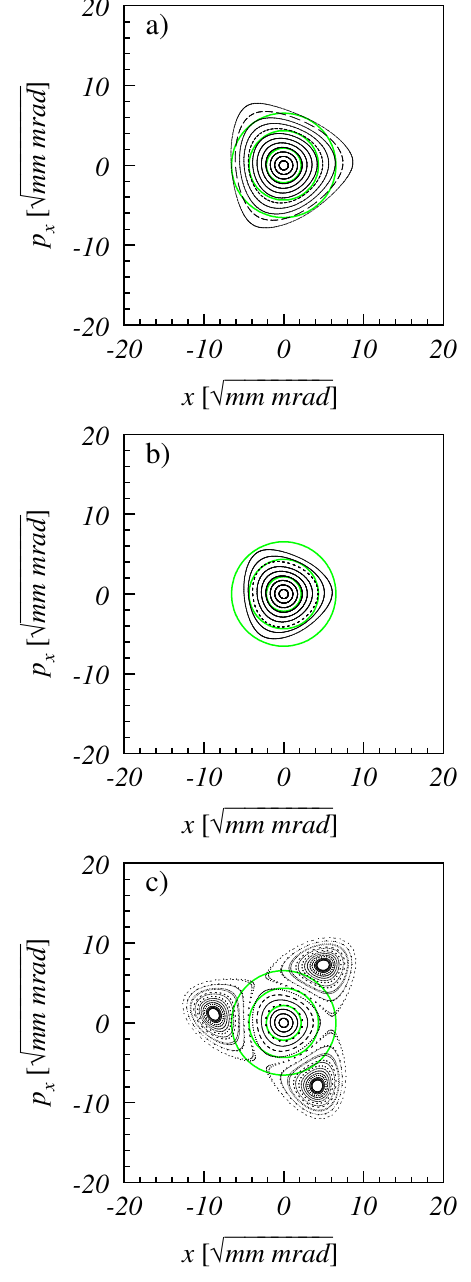
FIG. 9. Phase space portrait of the stable orbits for (a) Q x ¼ 4 : 328 , (b) Q x ¼ 4 : 334 , and (c) Q x ¼ 4 : 34 . In the particle dynamics are included, the magnet nonlinearities and the beam space charge.